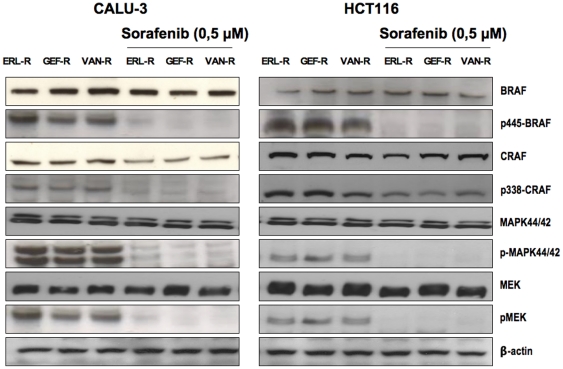
Western blotting analysis of CALU-3 and HCT116 cells TKI-resistant derivatives (ERL-R, GEF-R, VAN-R) following treatment with sorafenib.Western blotting analysis of C-RAF, B-RAF, MEK and MAPK activation following treatment with the indicated concentration of sorafenib of lung adenocarcinoma CALU-3 and colorectal cancer HCT116 cells TKI-resistant derivatives (ERL-R, GEF-R, VAN-R ). β-actin was included as a loading control.